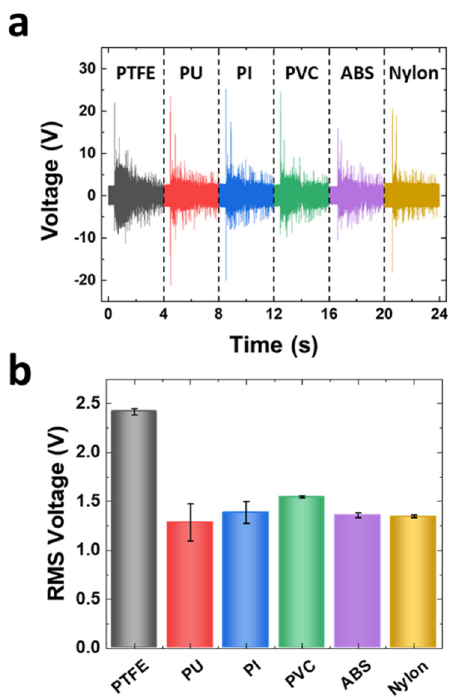
Figure 3. Electrical performance of Y-TENG for different materials of triboelectric layer. ( a ) Peak voltage and ( b ) RMS voltage output of the Y-TENG depending on various triboelectric materials.